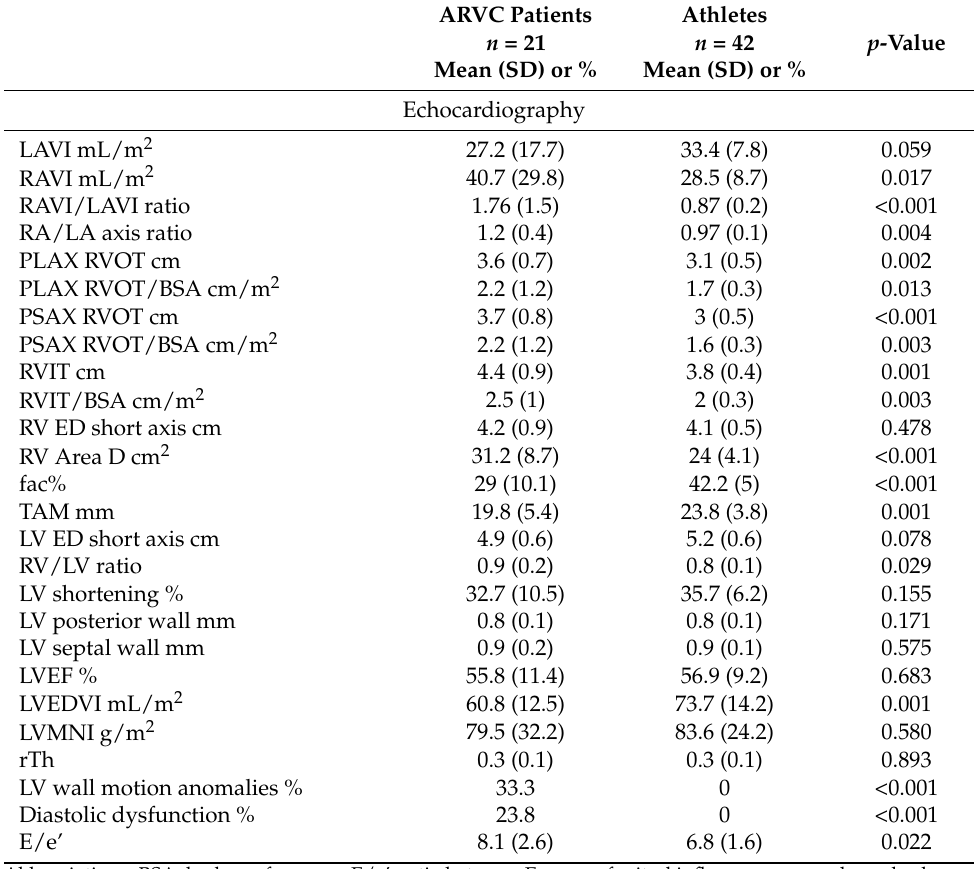
Table 2. Echocardiographic characteristics and 2010 Task Force Criteria for ARVC